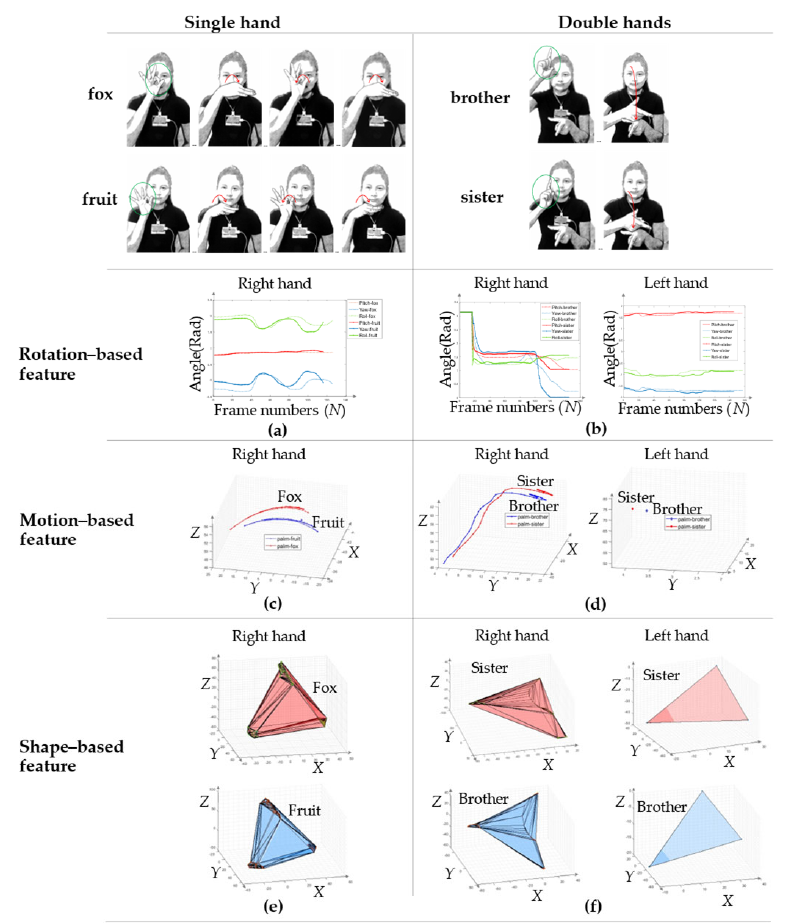
Figure 1. Problem analysis of different features used for similar sign words of ( a ) Rotation repre- sentation of hand of single hand; ( b ) Rotation representation of hand of double hands; ( c ) Motion representation of hand of single hand; ( d ) Motion representation of hand of double hands; ( e ) Shape representation of thumb, pinky, and wrist finger on time series of single hand; ( f ) Shape representation of thumb, pinky, and wrist finger on time series of double hands.